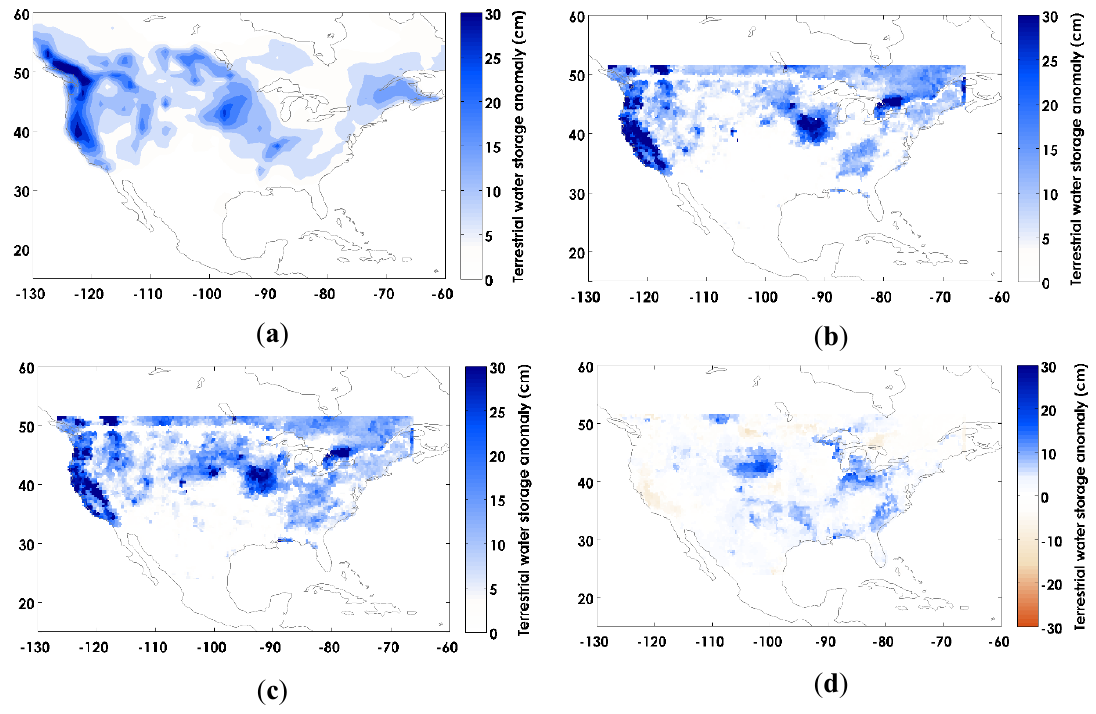
Figure 3. Pre-flood terrestrial water storage anomaly in March 2011: ( a ) GRACE observations; ( b ) CLSM open-loop simulation; ( c ) CLSM-DA assimilation simulation; ( d ) the difference between the two model simulations, CLSM-DA minus